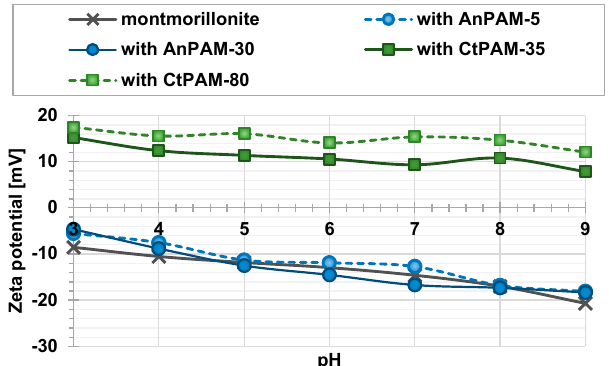
Figure 6. Influence of the presence of ionic polyacrylamide with different content of functional groups on the electrokinetic potential of montmorillonite particles as a function of solution pH, initial concentration of adsorbates is 100 mg/L.